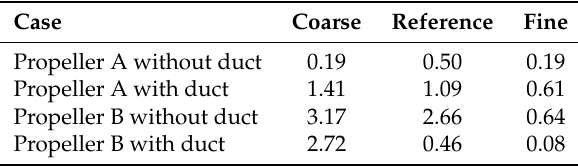
Table 2. Percentage variation of the total delivered thrust with respect to the extrapolated